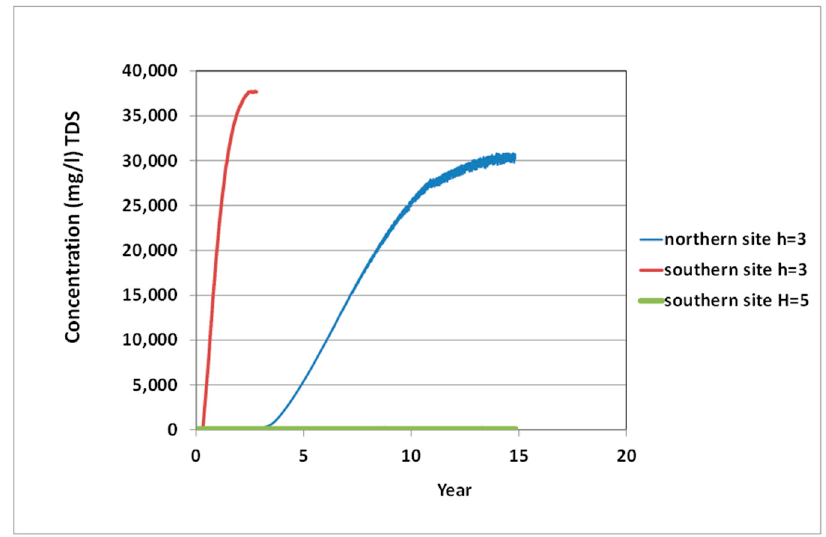
Figure 11. The simulated salinity in unit B at a distance of 70 m from the shore in the northern and southern sites (point 2 in Figure 10), for different boundary conditions (level of +5 and +3 m at the eastern model border).